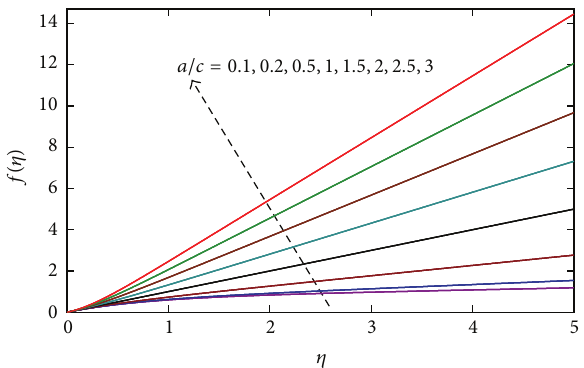
Figure 3: The variations of 𝑓(𝜂) for various values of 𝑎/𝑐 .